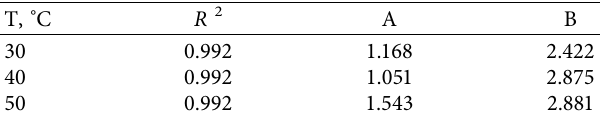
Table 7: Temkin parameters for Pb ions adsorption. T, ° C R 2 A